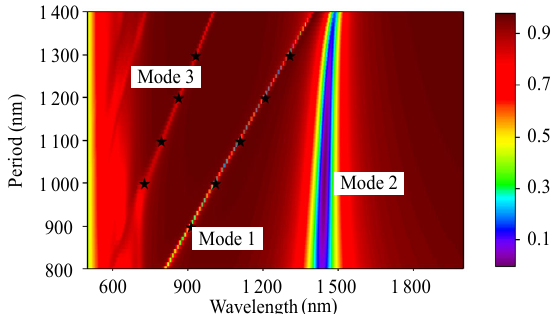
Fig. 7 Reflective spectra of the 2D grating composite structure. The period ranges from 800 nm to 1400 nm and the color represents the reflectivity distribution. The black stars show the resonance wavelengths calculated via theoretical analysis under different